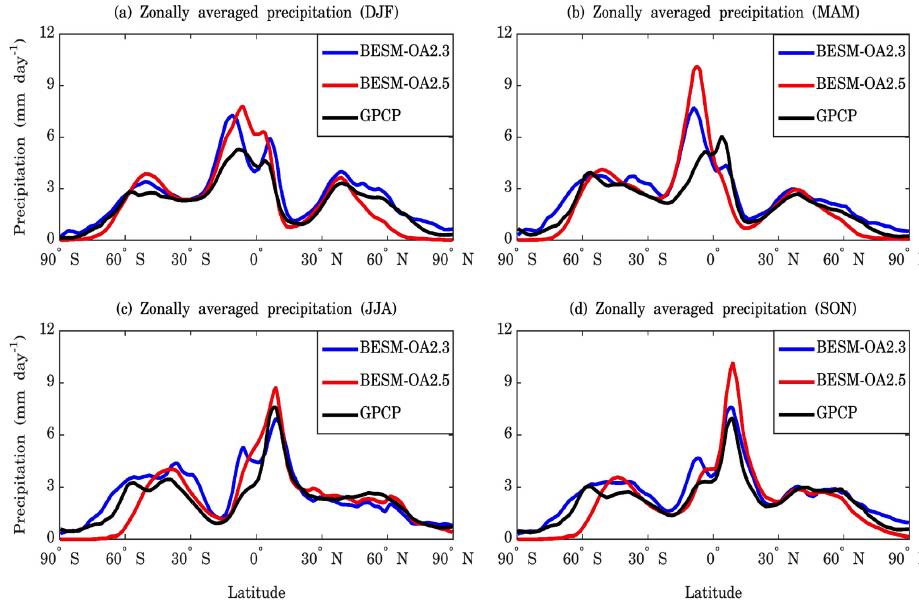
Figure 6. Zonally averaged annual mean precipitation for the BESM-OA2.5, BESM-OA2.3, and GPCP datasets relative to the seasons DJF, MAM, JJA, and SON. The zonally averaged values were computed over the periods 1971–2000 and 1979–2008 for BESM-OA2.5 and GPCP, respectively. Units are in millimeters per day.